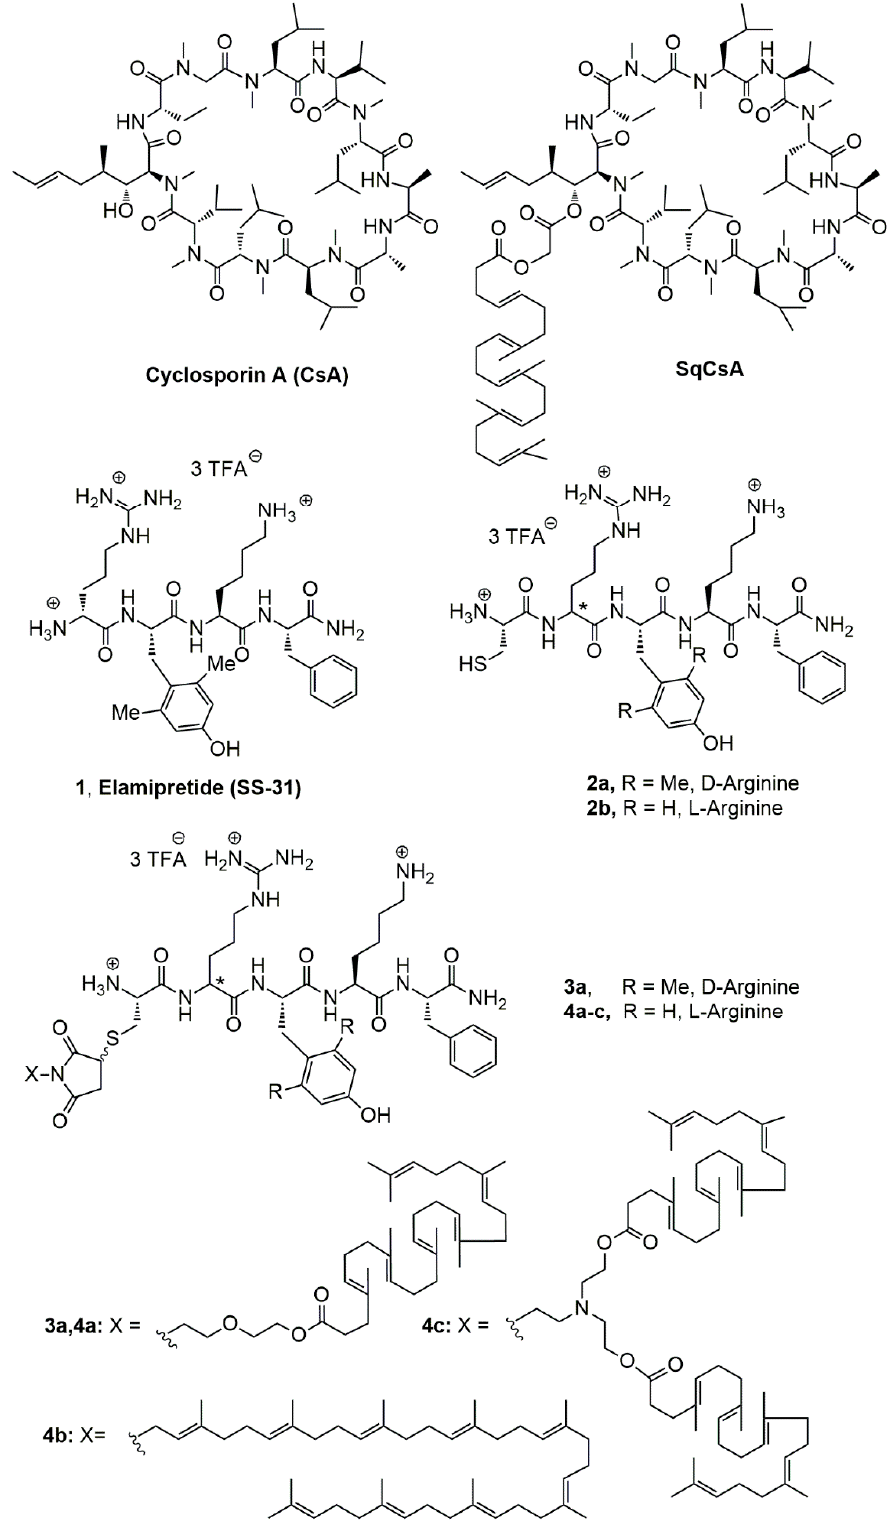
Figure 1. Structures of cyclosporin A (CsA), cyclosporin squalene conjugate (SqCsA), Elamipretide (SS-31), the cysteine bound peptides 2a , b and the poylyisoprenyl conjugates 3a – c , 4a . The chiral carbon atom of arginine is marked with an asterisk